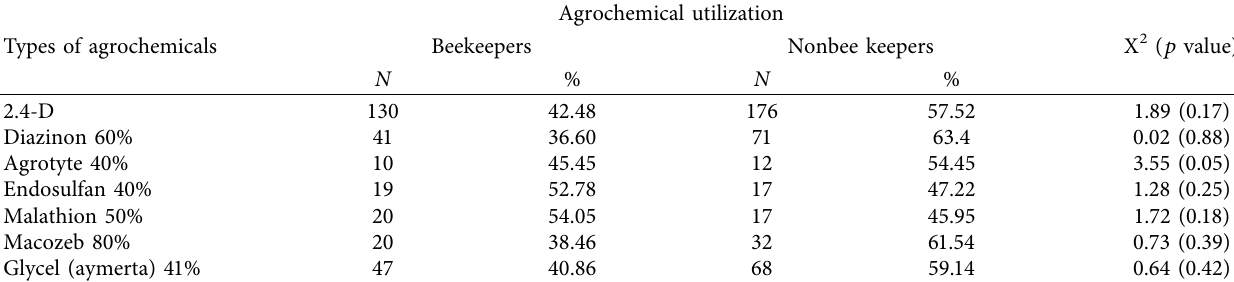
Table 5: Major types of agrochemicals used by respondents and statistical